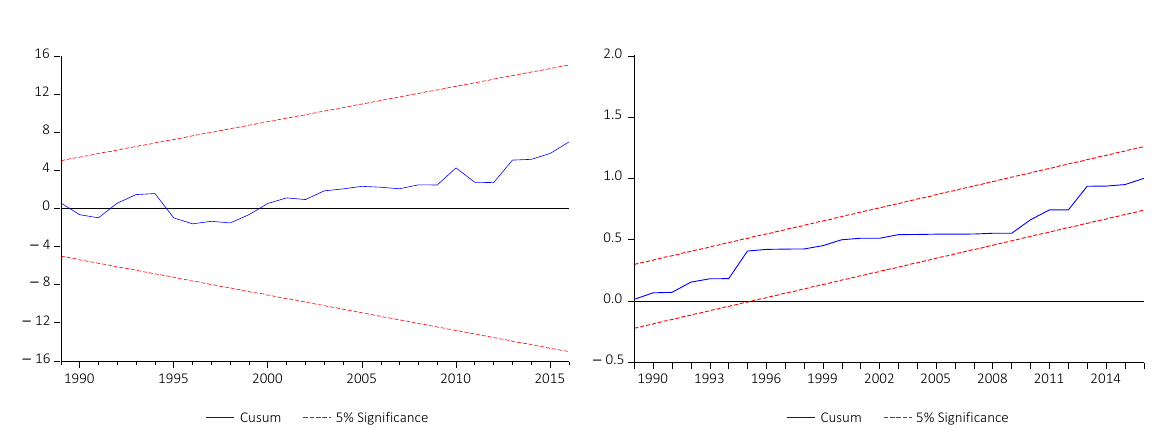
Figure A1. Plots of CUSUM and CUSUMSQ tests (NARDL